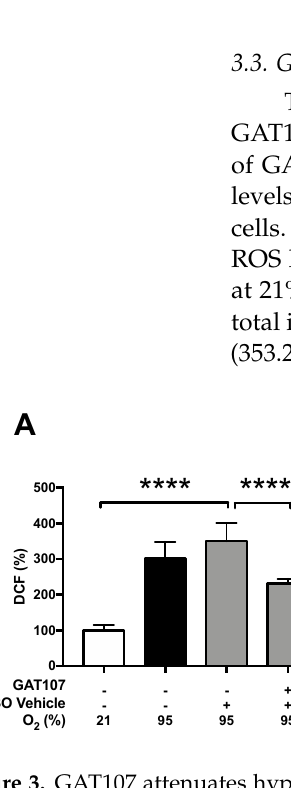
Figure 3. GAT107 attenuates hyperoxia-induced oxidative stress and decreases hyperoxia-induced actin oxidation and hyper-polymerization of actin in macrophages. RAW 264.7 were either exposed to 21% O 2 or 95% O 2 (hyperoxia) in the presence or absence of 3.3 µM GAT107. After 24 h of hyperoxic exposure ( A ), the fluorescent DCF signal of the macrophages was determined using the DCFH-DA assay and was quantitated spectrophotometrically and reported as a percent relative to the room air control to evaluate oxidative stress. ( B ) The total protein carbonylation, due to oxidation, was determined using the western blot assay. The 43kD immunoreactive band was used to evaluate the level of actin oxidation (as indicated by the arrow) based on 3–4 independent experiments per group. ( C ) The amount of actin polymerization was determined using the fluorescent micrographs obtained as described in Section 2.7, and the ratio of the occupied area of actin relative to the area of the nuclei, was reported as a percent of non-overlapping signals—obtained from ImageJ’s co-localization analysis plugin and computation of Manders’ Correlation Coefficient. Each value represents the mean ± SEM of three independent experiments for each group. Statistical differences were determined between all groups and indicated as **** p < 0.0001, ** p < 0.01 compared to the hyperoxia-exposed vehicle control